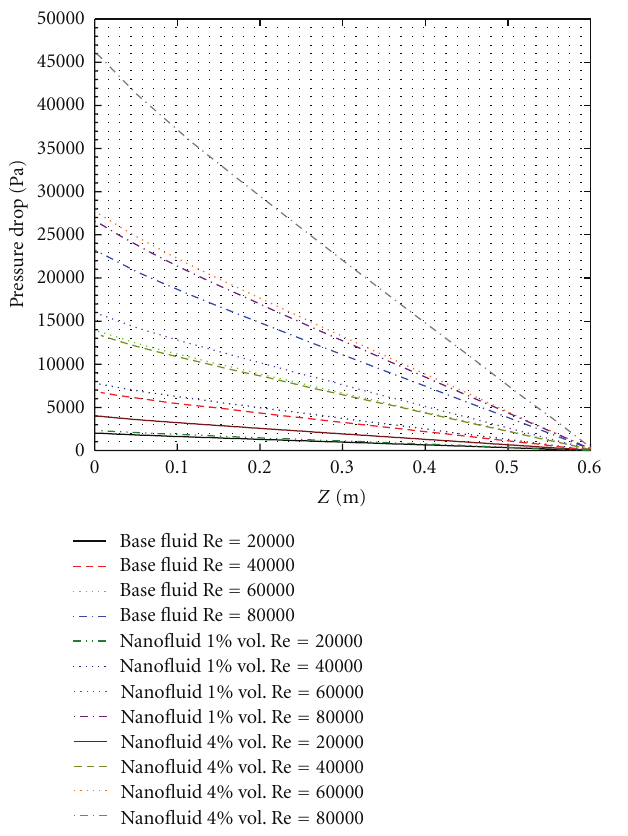
Figure 11: Pressure distribution in subchannel for di ff erent volume concentration and Re.